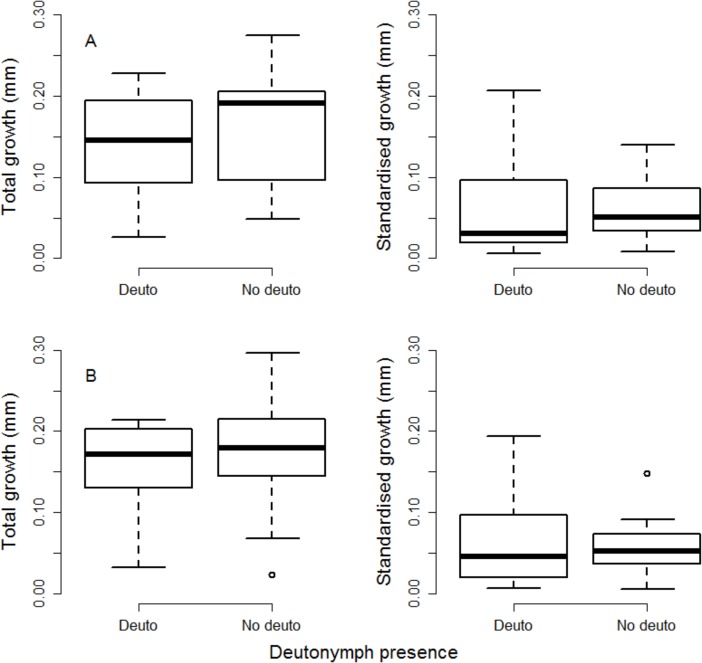
Compensatory growth.Total growth (mm) and standardised growth (mm per day per tritonymph length) during the tritonymph stage, as a function of deutonymph presence (Deuto) or deutonymph absence (No Deuto) during development in females (A) and fighter males (B). Boxes represent upper and lower quartile ranges, middle bands are medians and whiskers represent the extremes. Outliers are shown as points.